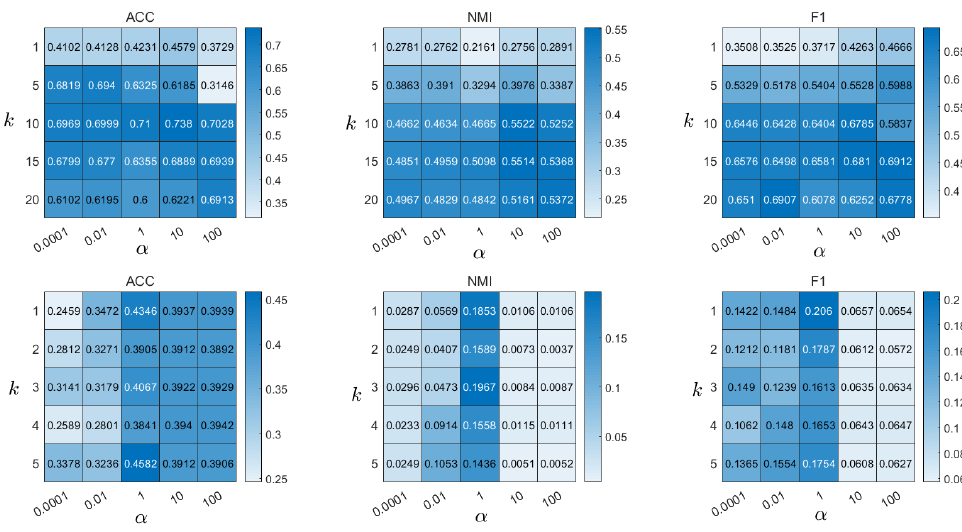
Figure 2. The influence of parameters k and α on results of Cora (first row) and Large Cora (second row) datasets in